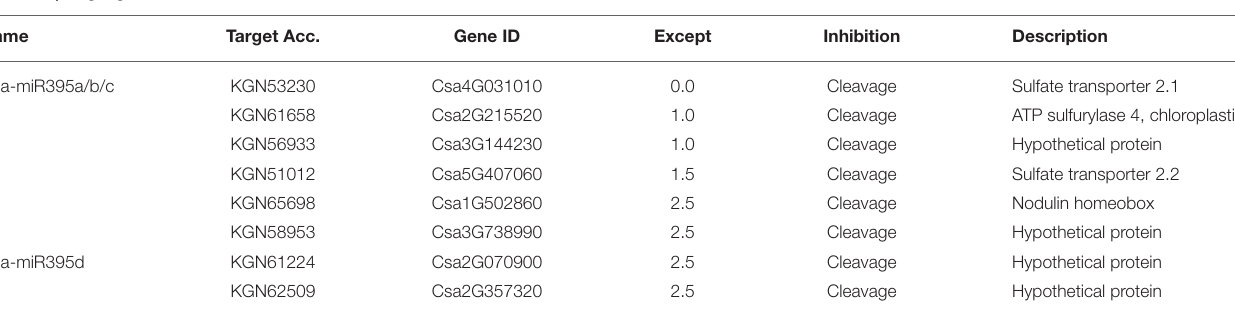
TABLE 1 | Target genes of